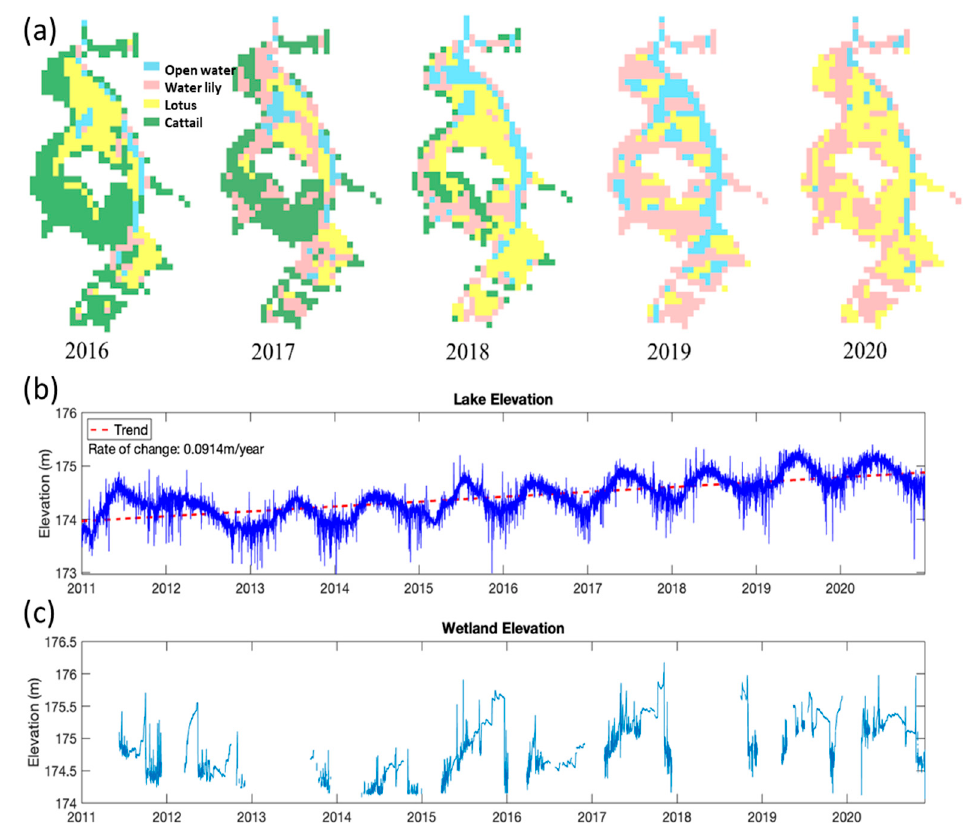
Figure 7. ( a ) Time sequence of patch location and extent in OWC, produced by the classification of HLS data from 2016 to 2020. ( b ) Rapid increases in Lake Erie’s water elevation over the last decade (data from NOAA, https://tidesandcurrents.noaa.gov/ (31 December 2021)) have led to ( c ) higher water levels in the OWC wetland area (data from NERR https://cdmo.baruch.sc.edu/ (31 December 2021)) and noticeable changes in the patch type composition. Cattail , which was the most